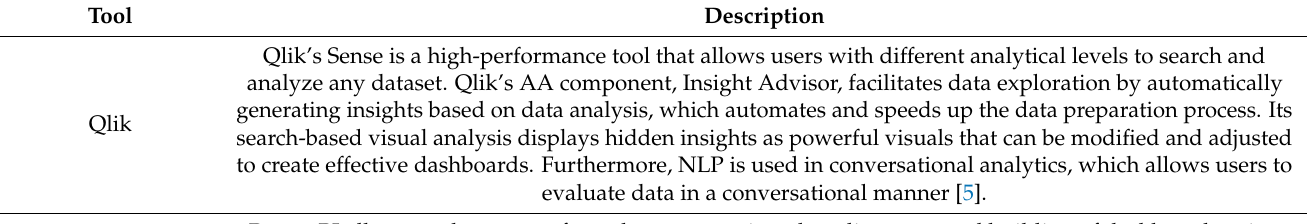
Table 2. Popular platforms that leverage AA features.